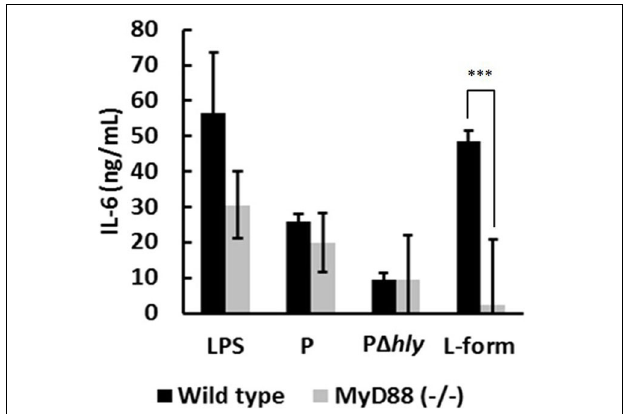
FIGURE 6 | Interferon- β (IFN- β ) induction in macrophages infected by wild type, and (cid:2) hly ScottA-GFP (parental and L-form). Gene expression was measured by Real-Time qRT-PCR, values were normalized to the house-keeping gene β -actin, and expression levels of negative controls (soft agar, medium) were subtracted. Data represent means ± s.e.m. Statistical analysis was performed using the unpaired Student’s t -test: ∗∗ P < 0 . 01.